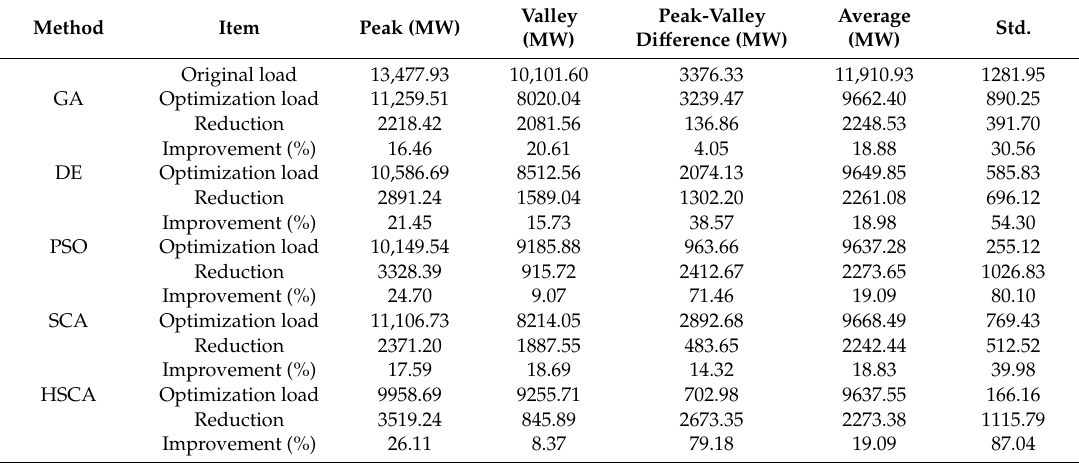
Table 9. Comparison of original load and optimized loads obtained by five algorithms in spring. Method